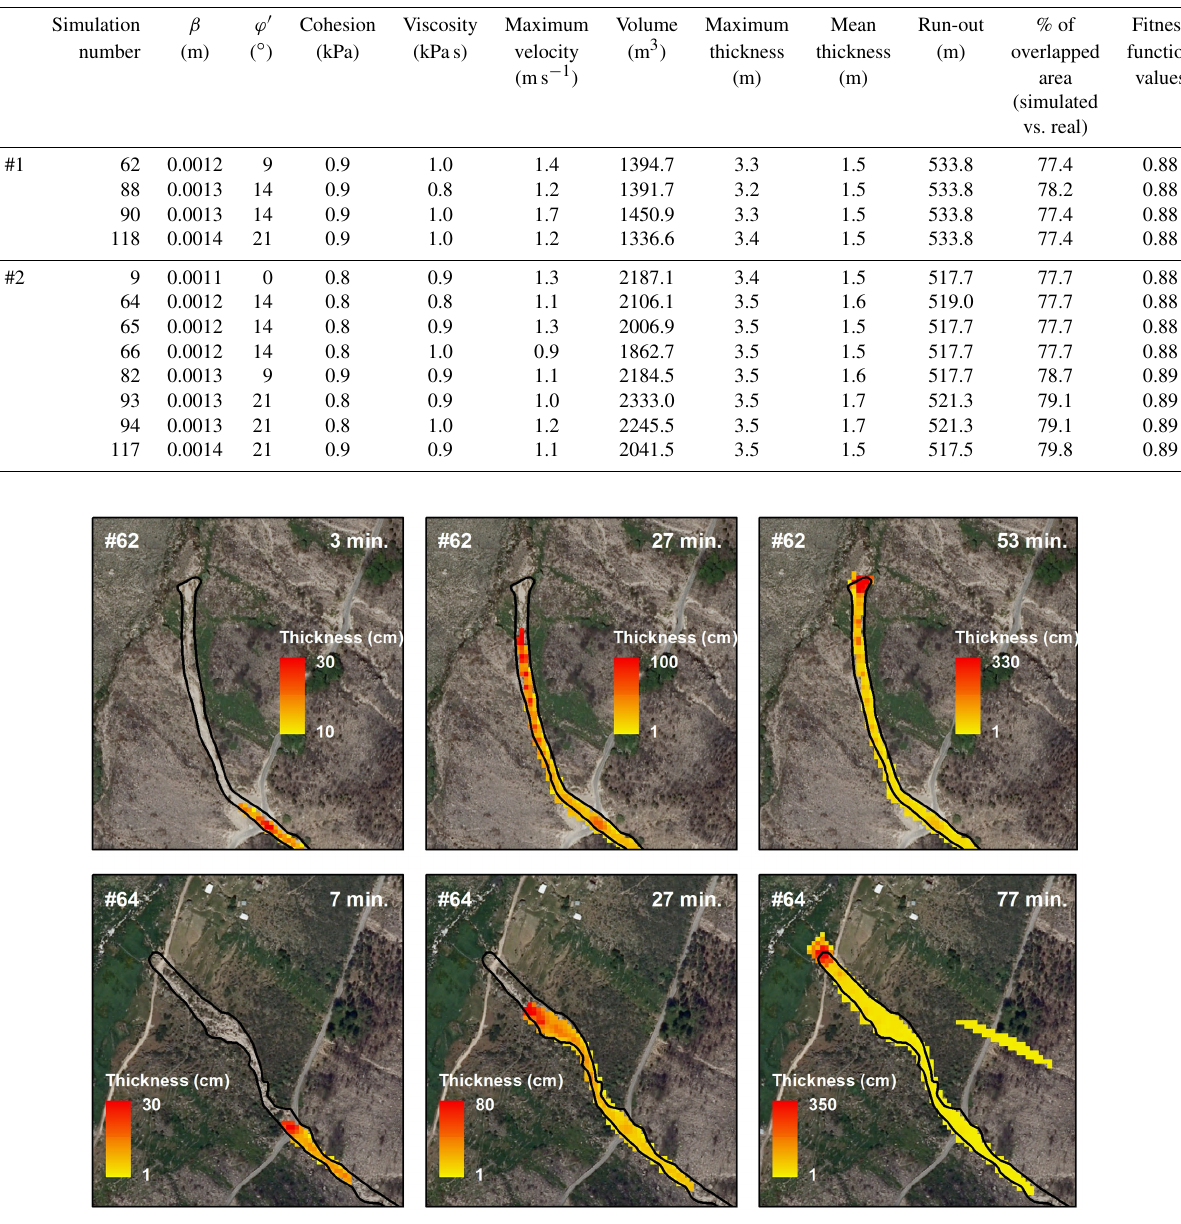
Table 4. Parameters used and estimations obtained for the most accurate simulations.